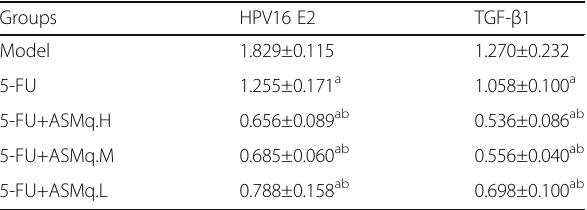
Table 5 The effects of 5-FU combined with Abnormal Savda Munziq on the protein expression of HPV16 E2 and TGF- β 1 in mice bearing U27 cell-induced tumors ( x ± s